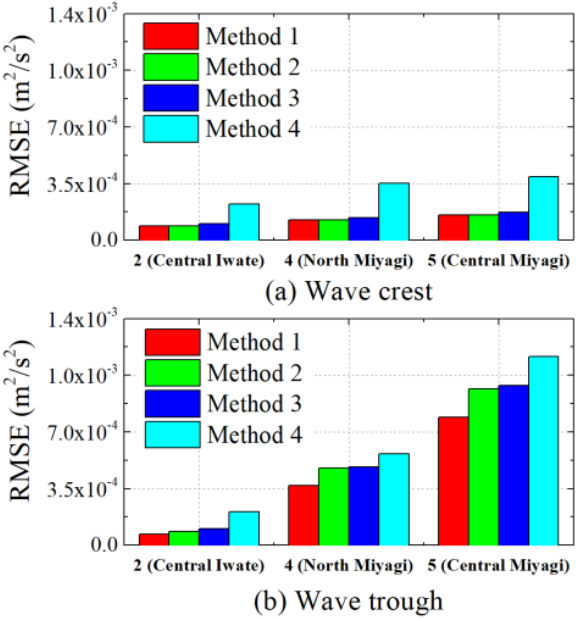
Figure 15. RMSE of each calculation method.